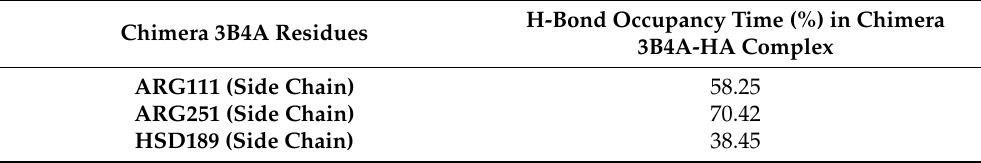
Table 5. Hydrogen bond (H-bond) occupancy of Chimera 3B4A–HA complex. Hydrogen bonds are measured with a cut-off distance of 3.5 Å and occupancy time > 5% are displayed in the